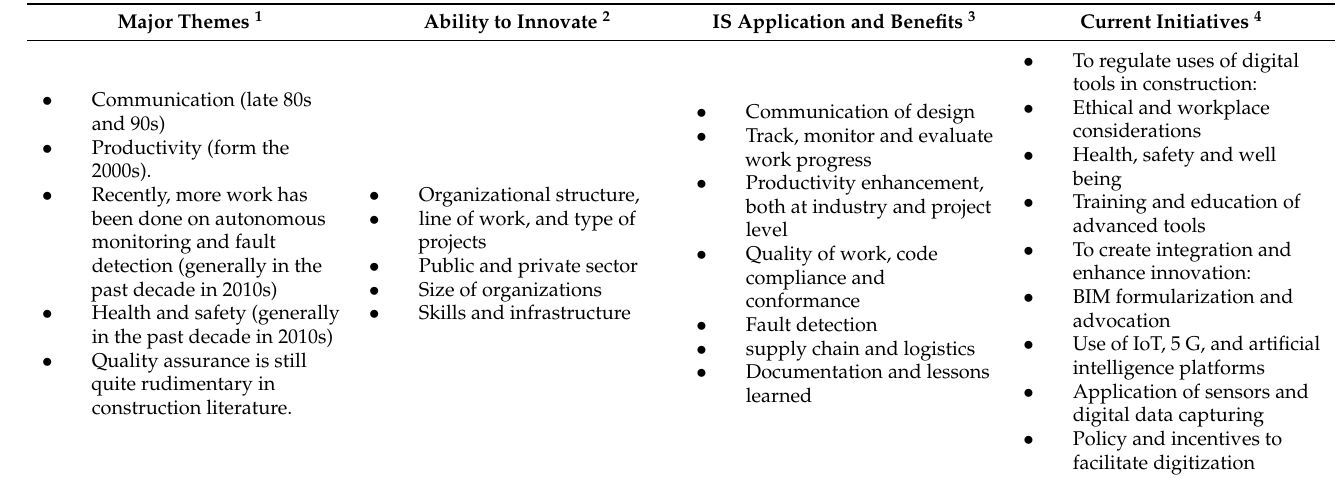
Table 1. Classification of IS and technology literature in